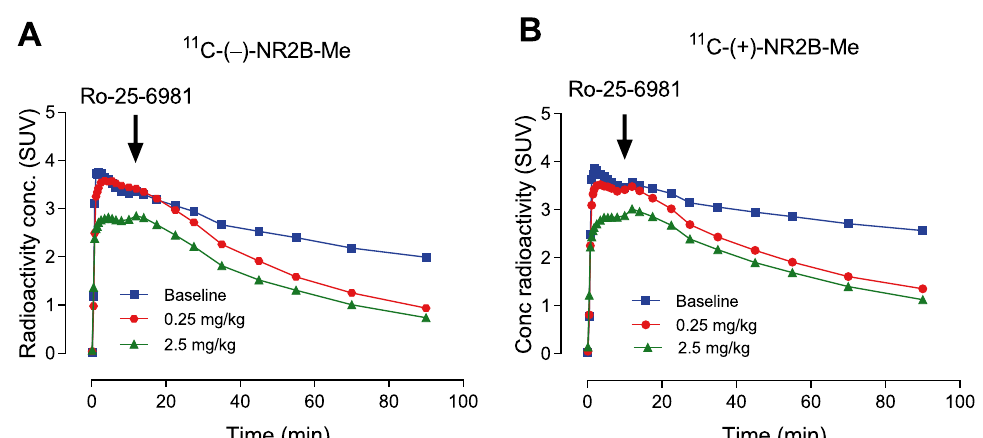
Fig. 2 Whole brain time‑activity curves for 11 C‑( )‑NR2B‑Me ( A ) and 11 C‑( )‑NR2B‑Me ( B ) with different displacement doses of the GluN2B ligand − + Ro‑25‑6981 at 10 min after radioligand injection. Displacement by 0.25 mg/kg of Ro‑25‑6981 at 90 min for panel A was 63%, whereas that for panel B was 46%. Data are for n 1 =